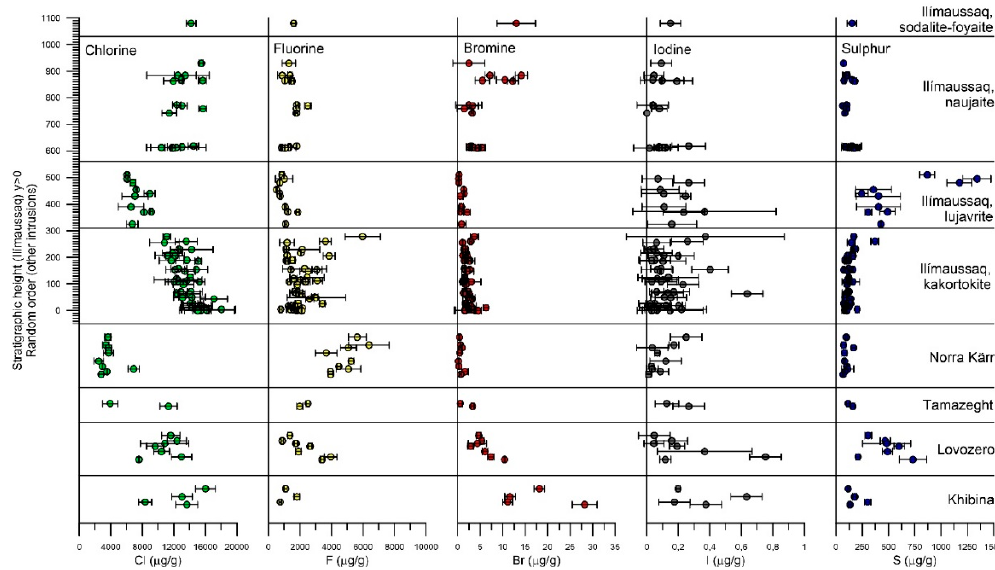
Figure 3. Halogen (Cl, F, Br, and I) and S concentrations in EGM based on CIC measurements. Ilímaussaq samples are sorted according to their stratigraphic height in this intrusion, samples from the other four intrusions are randomly ordered.